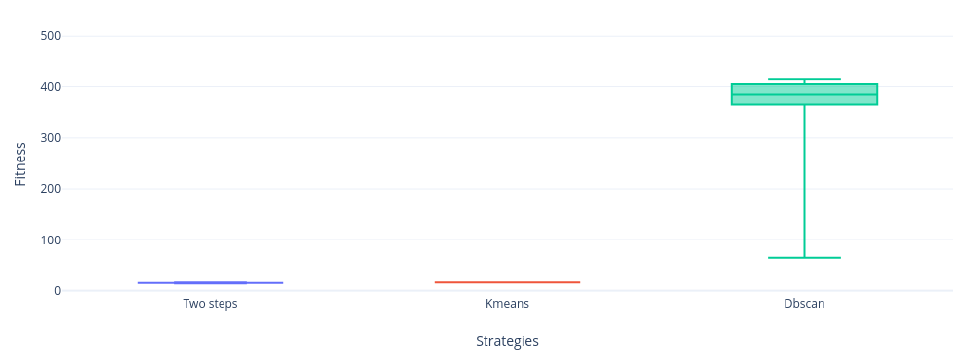
Figure 16. Instance nrf.5 distribution.